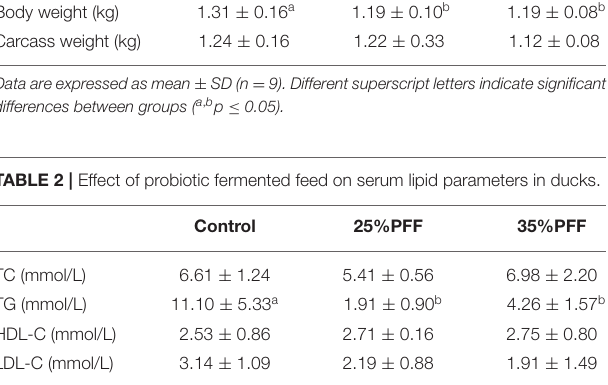
TC, total cholesterol; TG, triglycerides; HDL-C, high-density lipoprotein cholesterol; LDL- C, low-density lipoprotein cholesterol. Different superscript letters indicate significant differences between groups ( a , b p ≤